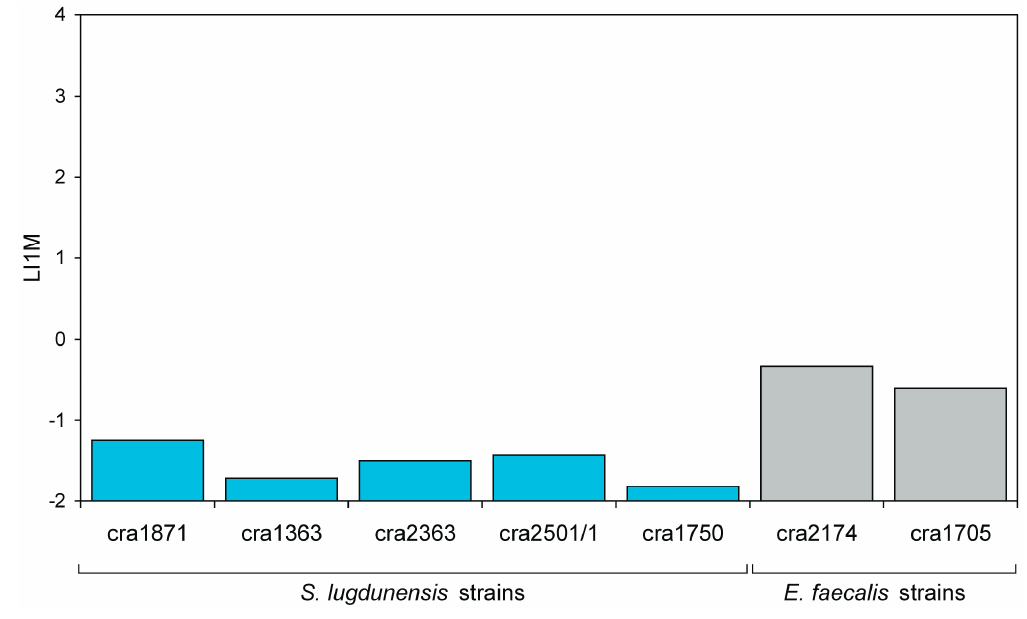
Figure 10. LI1M values calculated for S. lugdunensis and E. faecalis strains.